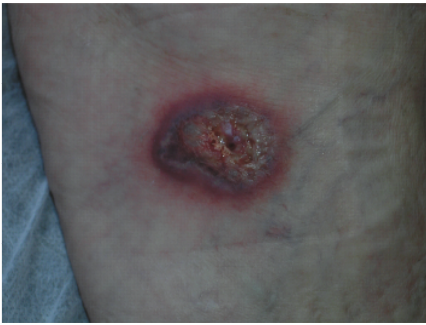
Figure 3: Ulceration and peripheral stromal infiltrates in the upper and lower limb (slit